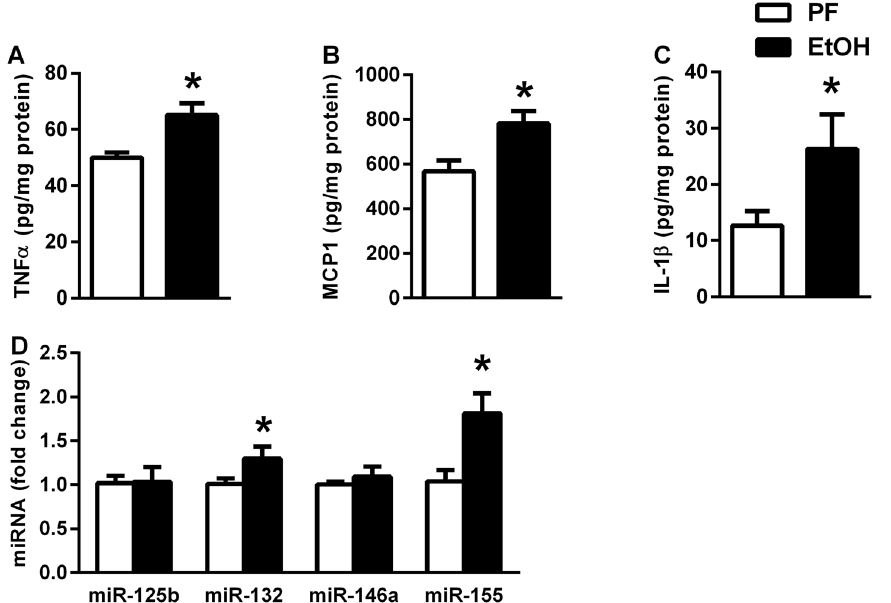
Figure 1. Pro-inflammatory cytokines and microRNAs are increased in alcohol-induced brain injury. WT mice were fed with control (PF, n=7) or EtOH (n=8) diet for 5 weeks. Inflammatory cytokines, TNF a (A), MCP1 (B) and IL-1 b (C) were measured by specific ELISAs on whole cerebellar lysates, and corrected with total protein. Various microRNAs (125b, 132, 146a, 155) were measured by real-time PCR on whole cerebellar miRNA extract and corrected with snoRNA202 (D). Bars represent mean 6 SEM (*: p value , 0.05 relative to appropriate PF controls by Kruskal-Wallis non- parametric test).